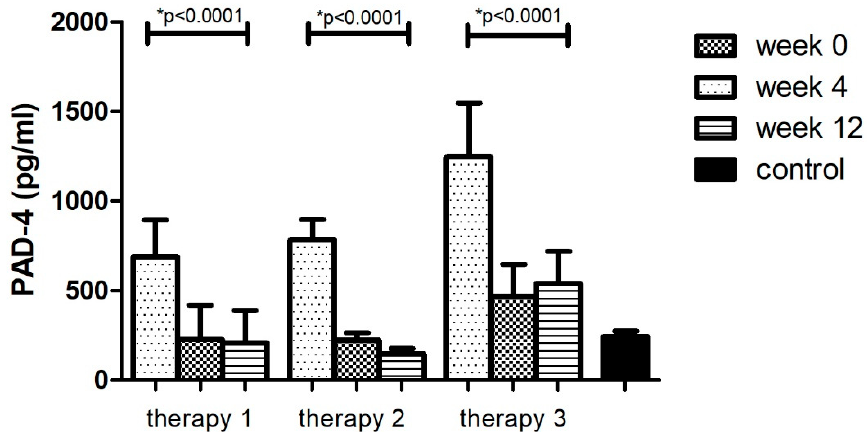
Table 8. PAD-4 level (pg/mL) between treatments: MTX (therapy 1, n = 20), anti-TNF α (therapy 2, n = 20) and anti-IL-17A (therapy 3, n = 10) in patients with plaque psoriasis at three measurement points (week 0, week 4, week 12). * indicates a statistically significant difference ( p < 0.05).